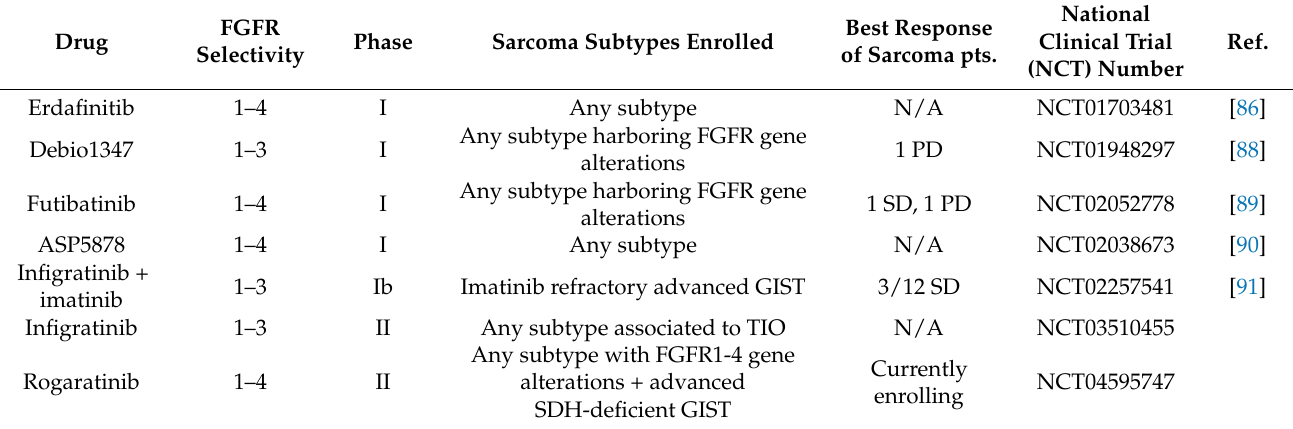
Table 2. Clinical trials evaluating selective FGFR TKIs in sarcoma